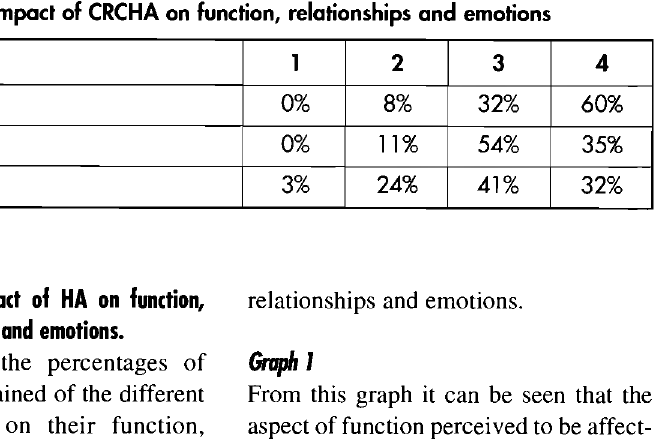
3. Self-perceived impact of HA on function, social relationships and emotions.